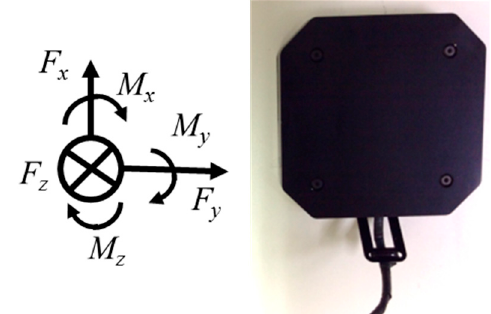
Figure 3. The wearable force plate system consists of four 3-axis compact force sensors. The force plate output 3-axis force and 3-axis moment.